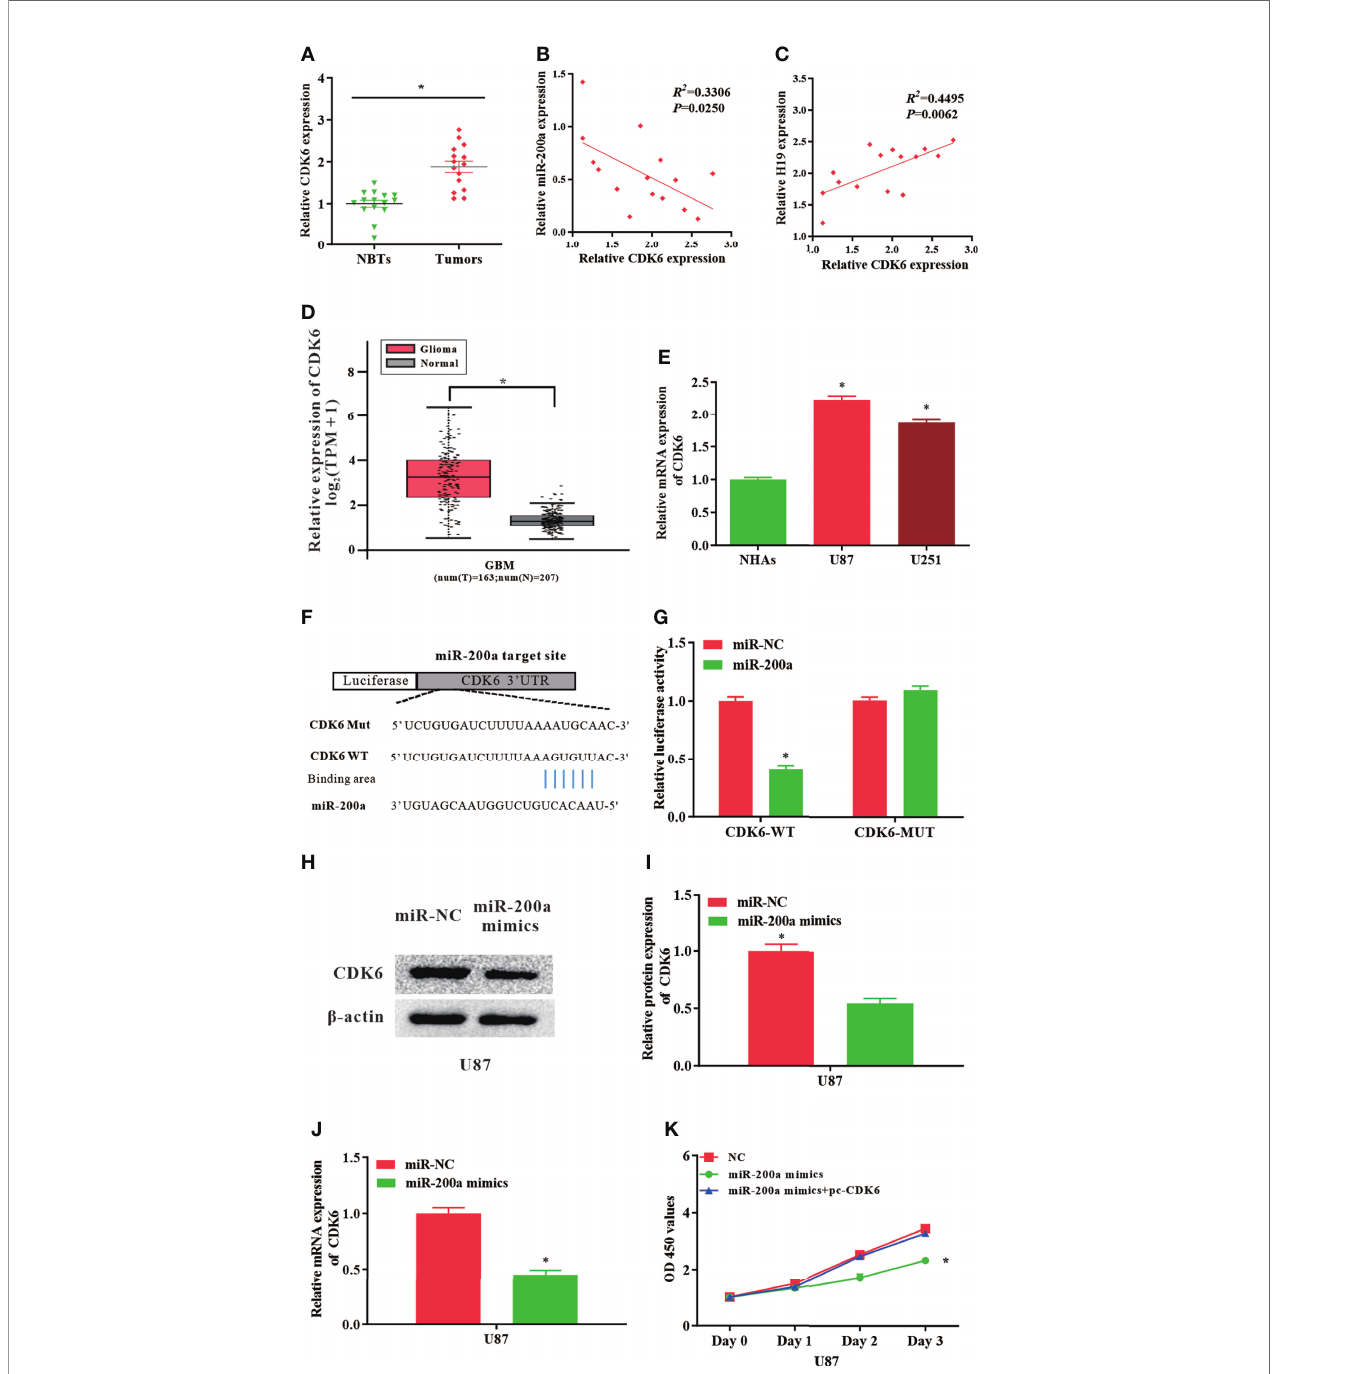
FIGURE 3 | CDK6 levels are regulated by miR − 200a in glioma cells. (A) CDK6 expression was assessed in glioma tissues and paired para − tumorous. (B) The RNA levels of CDK6 and miR − 200a inversely correlated in glioma tissues (R 2 = 0.3306; P = 0.0250). (C) The RNA levels of CDK6 and H19 correlated in glioma tissues (R 2 = 0.4495; P = 0.0062). (D) GEPIA database revealed that CDK6 expression is remarkably up-regulated in glioma tissues (GBM, T = 163, N = 207). Boxplot illustrated log2 (TPM+1) on a log-scale. (E) CDK6 expression was up-regulated in glioma cells (U87-MG and U251) compared with NHAs. (F) Putative binding sites between miR-200a and CDK6 transcripts. (G) Overexpression of miR-200a lead to signi fi cant reduction of CDK6-WT-dependent luciferase activity, whereas no change was detected in mutant control. (H, I) Protein levels of CDK6 in U87-MG cells transfected with miR − NC/miR − 200a mimics were determined by western blotting. (J) RT − qPCR was performed to evaluate the CDK6 expression in transfected U87-MG cells. (K) CCK-8 assay was performed to determine the proliferation of U87-MG cells treated with miR-200a mimics or co-transfected with miR-200a mimics and pc-CDK6. Data were presented as mean ± SEM; * P < 0.05 vs NHAs or control group. NHAs, normal human astrocytes; NBTs, normal brain tissues; NC, negative